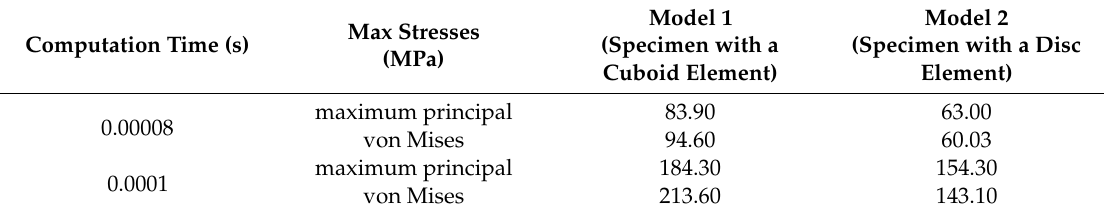
Table 4. Values of the Max Principal Stress and the von Mises Stress in the adhesive layers for different computation times (linear analysis).